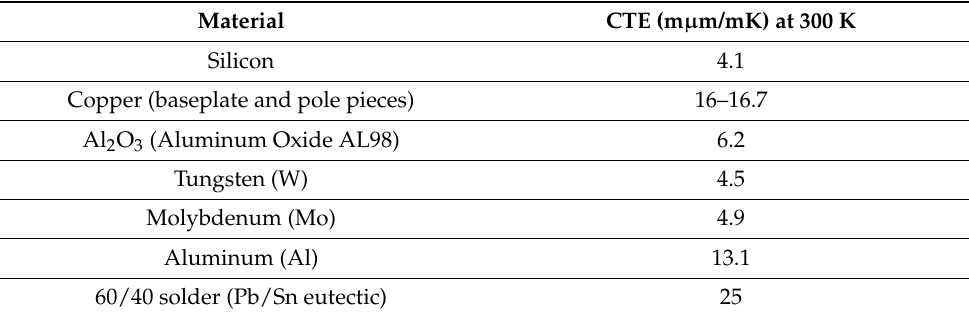
Table 1. Coefficient of thermal expansion for chosen